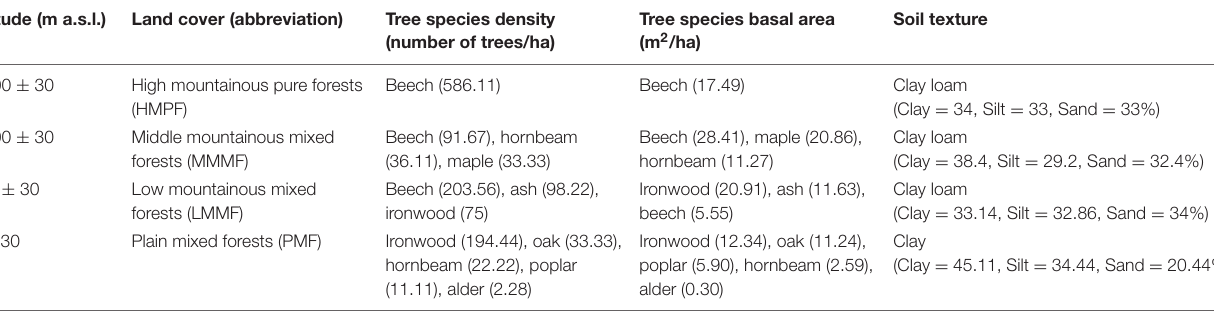
FIGURE 1 | The study site at the Experimental Forest Station, Vaz watershed in the Central Caspian region of northern Iran, and tree species composition along the altitudinal gradient in the Alborz Mountains. The tree species growing in the area were Fagus orientalis Lipsky (beech), Parrotia persica C.A.M. (ironwood), Carpinus betulus L. (hornbeam), Quercus castaneifolia C.A.M. (oak), Fraxinus excelsior L. (ash), Acer velutinum (maple), Alnus subcordata C.A.M. (alder), and Populus alba caspica Bornm (Persian poplar). TABLE 1 | Distribution of forest types and properties along an altitudinal gradient in the Hyrcanian forest profile (Vaz catchment, Alborz Mountains, northern Iran). Altitude (m